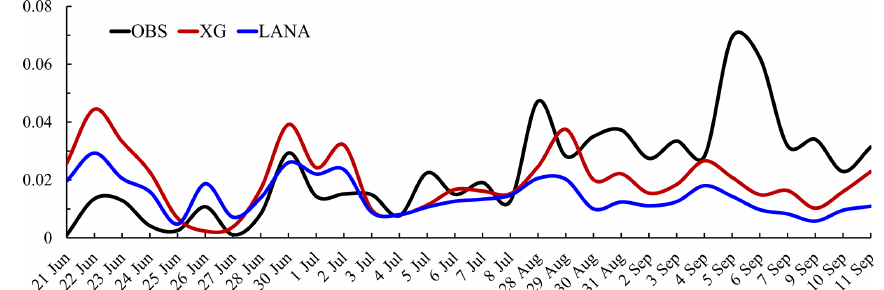
Figure 5. A comparison of simulated daily concentrations of MSA with observations at the Hua Niao Island site (units: µgm − 3 ).